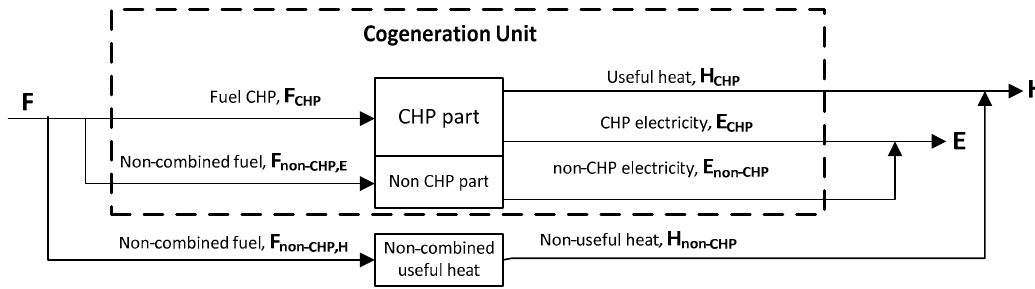
Figure 2. Scheme of a combined heat and power (CHP) unit with energy flows. The guidelines describe the procedure to split the cogeneration unit in a CHP and a non-CHP part for efficiencies below the minimum required